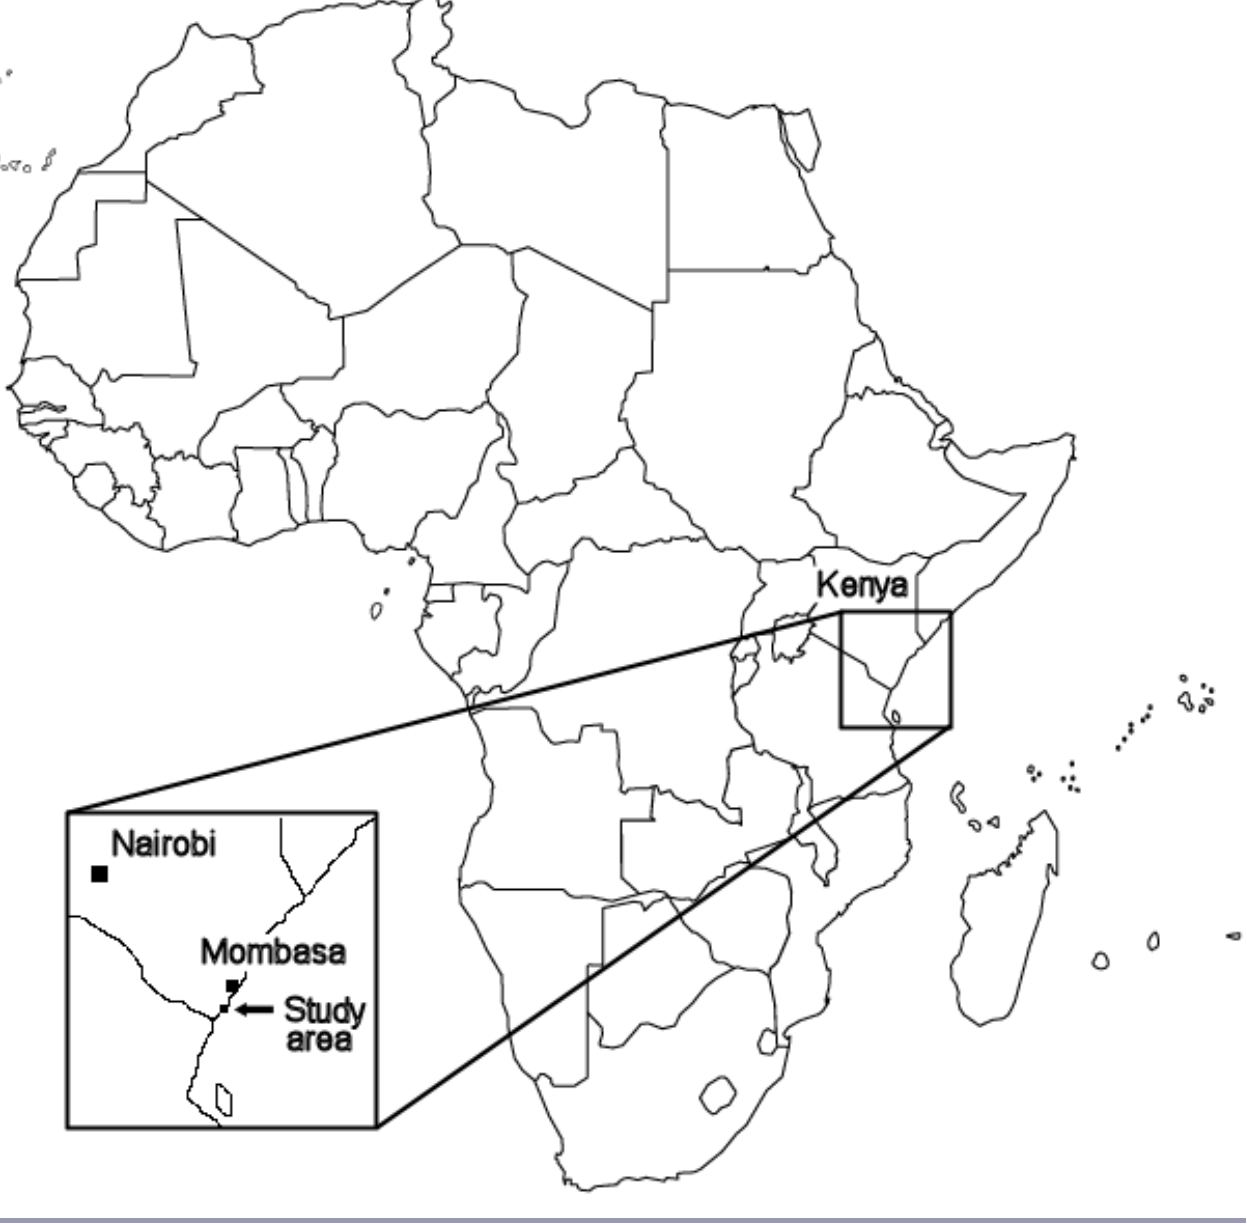
Fig. 1. Map of the study area with the target community indicated in the inset of the left hand corner. The area is located on the southern Kenyan coast at 4°25’S and 39°50’E, approximately 50 km south of